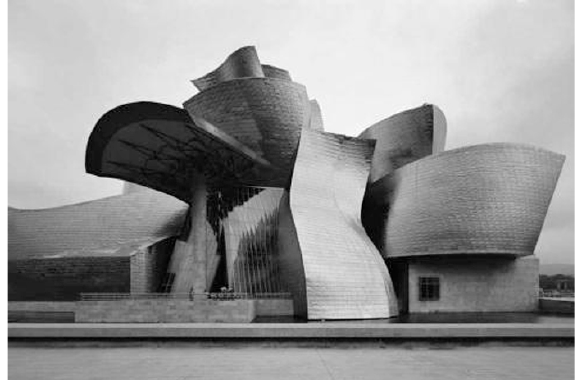
fig. 3. Bilbao Guggenheim Museum